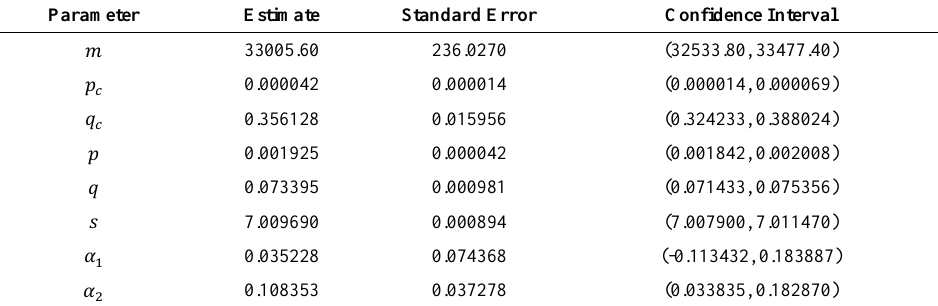
Table A17. Piedmont. Estimates, asymptotic standard errors and 95% mCIs for the parameters of the DMPseas